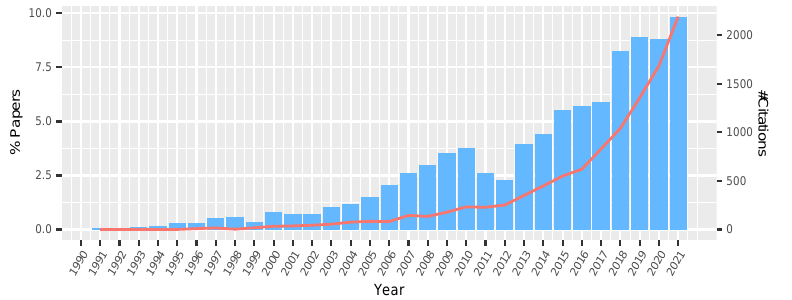
Figure 1. Percentage of publications (left axis) and total number of citations (right axis) related to emotional artificial intelligence from 1983 to 2021 obtained from Web of